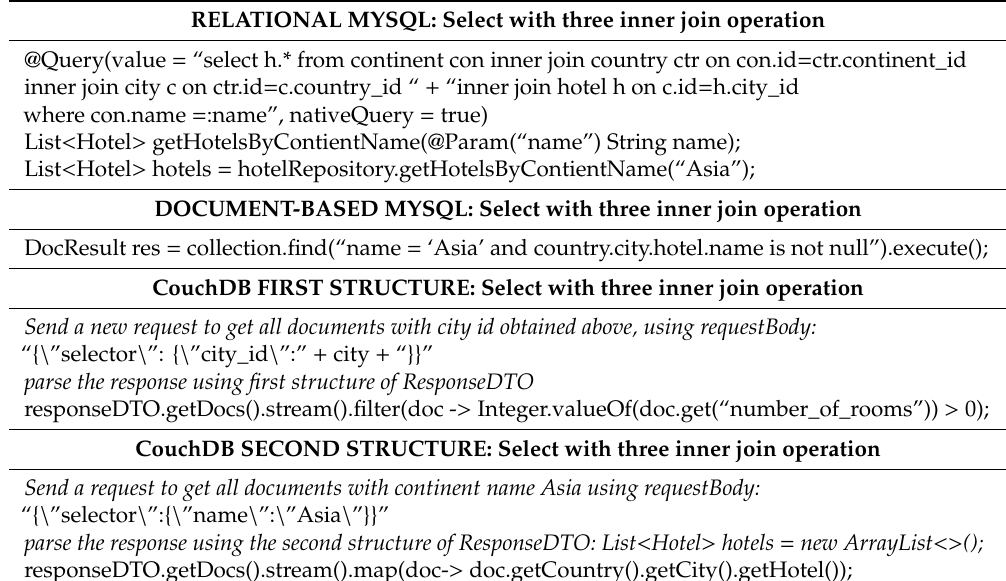
Table 7. Complex select with three inner join operations.